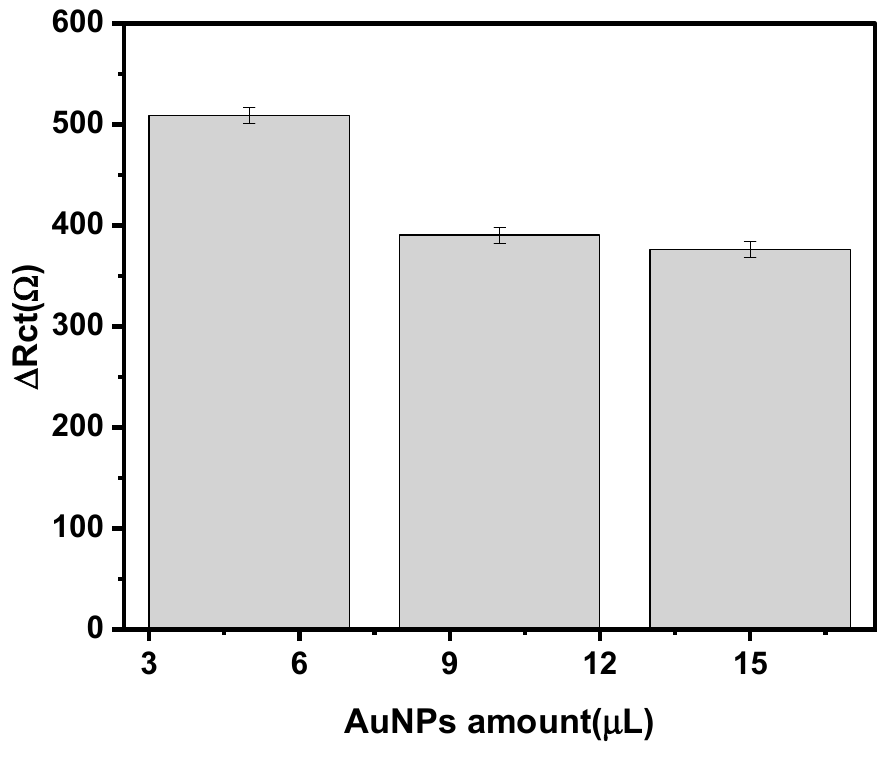
Figure 2. The optimization of the AuNPs’ modifier amount.